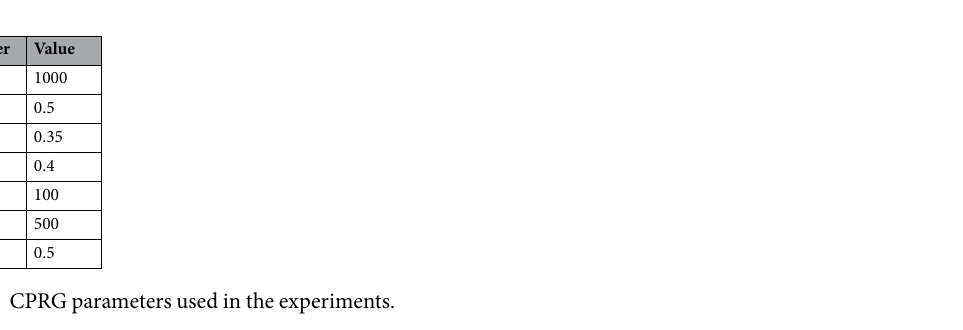
Figure 1. Basic resource dynamics: G describes the growth added to the resource depending on the current resource level N ; H describes the harvest taken from the resource, depending on resource level N and cumulative effort X . Here the limitations of the harvest are shown with the minimum and maximum cumulative effort respectively ( α = 0.4, β = 0.35, r g = 0.5, N max = 1,000, see Table 1).